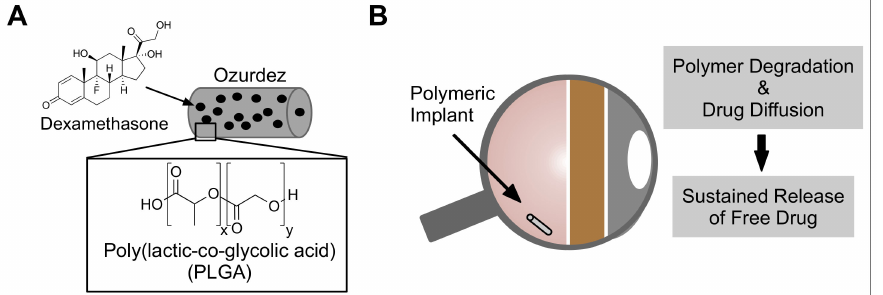
Figure 9. Drug encapsulation into biodegradable polymeric implant for extension of drug retention time and reduction in dosage frequency. ( A ) Ozurdez is an ocular implant consisting of dexametha- sone entrapped in PLGA polymeric scaffold. ( B ) Biodegradable polymeric implant is intravitreally injected within the eye, slowly releasing free drug by polymer degradation and drug